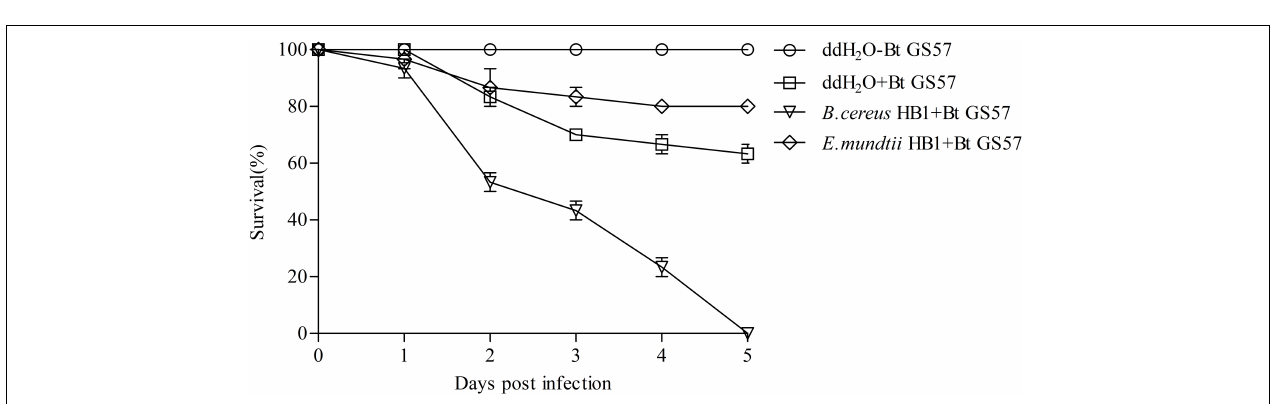
FIGURE 6 | Effect of the gut microbiota on Bt GS57 in Spodoptera exigua . (A) Survival of axenic and non-axenic S. exigua ( n = 45) following infection ( + Bt GS57) or non-infectioun ( − Bt GS57) with Bacillus thuringiensis . (B) The gut culturable bacterial load from axenic-Bt GS57, non-axenic + Bt GS57, and non-infected + Bt GS57 of S. exigua ( n = 3) at 0, 24, 48, and 72 h post-Bt GS57 infection. Bacterial load was determined by plating the homogenate of S. exigua guts with 100,000 dilutions on LB agar plates.